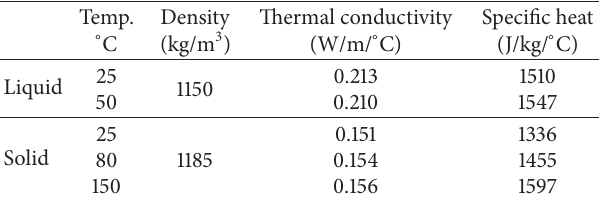
Table 2: Thermal properties of silicone